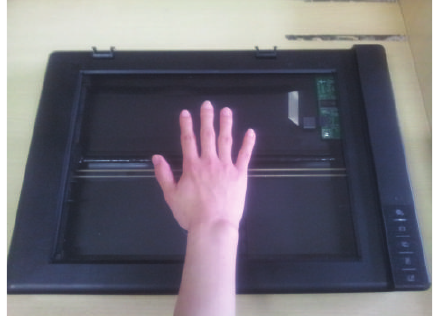
Figure 2: The palmprint data collection system.